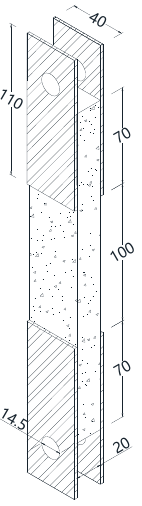
Figure 5. Dimensions of the TRM specimens (units: mm).